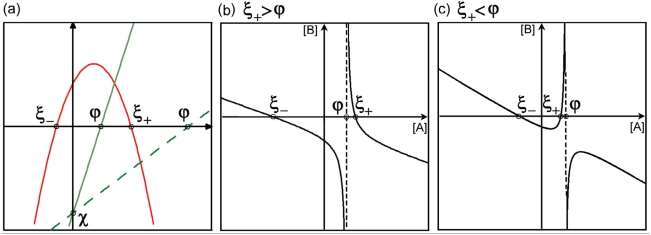
Qualitative shapes of the nullclines.(a) Graphical representation of the nullcline's components. The numerator is the parabolic curve and the denominator the straight line. Two feasible scenarios are shown: the solid line denotes ξ+>ϕ, the dashed line corresponds to ξ+<ϕ. (b),(c) Qualitative behaviour of the nullclines applying the two possible conditions.